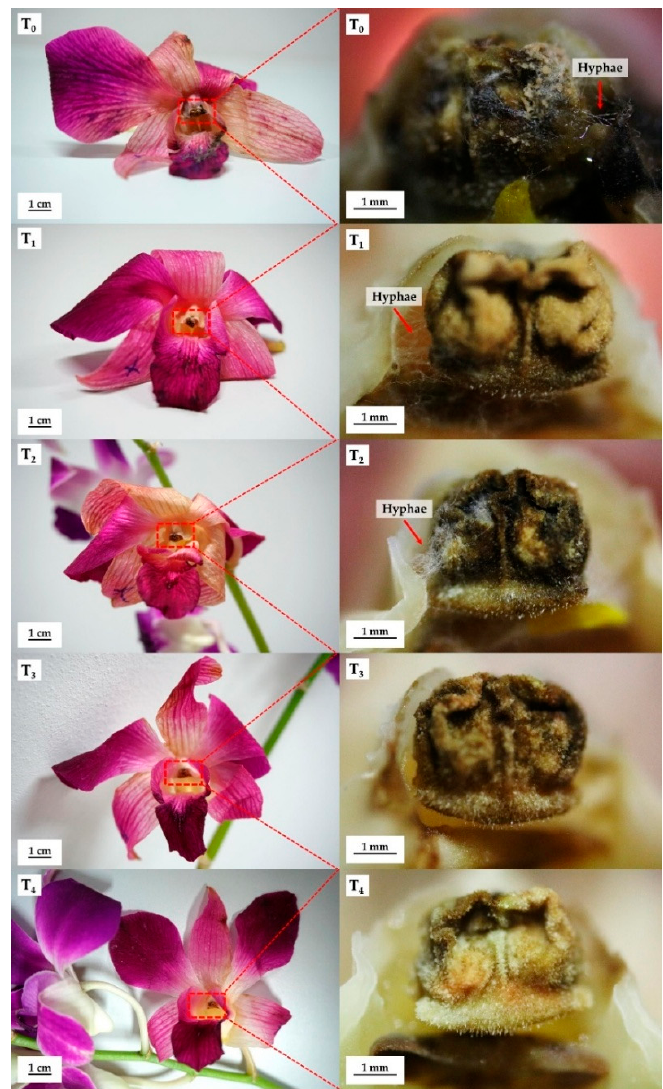
Figure 5. Photographs of cut orchid flowers (left) and respective anthers (right), after being stored for 7 days during the packaging test. Hyphae formations can be observed for T 0 , T 1 , and T 2 treatments. On the other hand, no C. gloeosporioides hyphae formation is observed on the anther for T 3 and T 4 treatments.